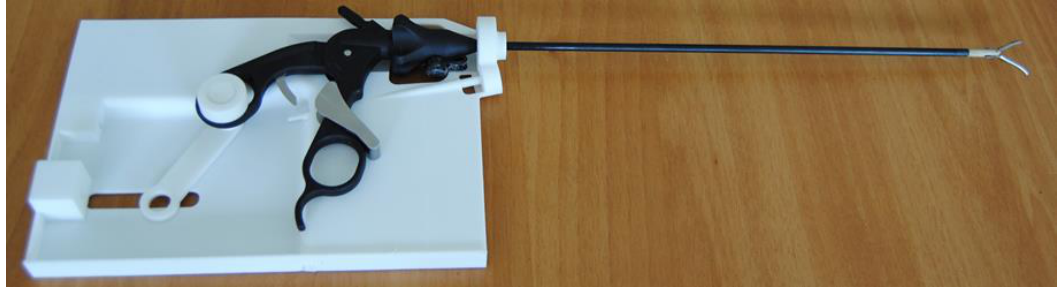
Figure 10. 3D printed prototypes of the bevel gear pair elements.